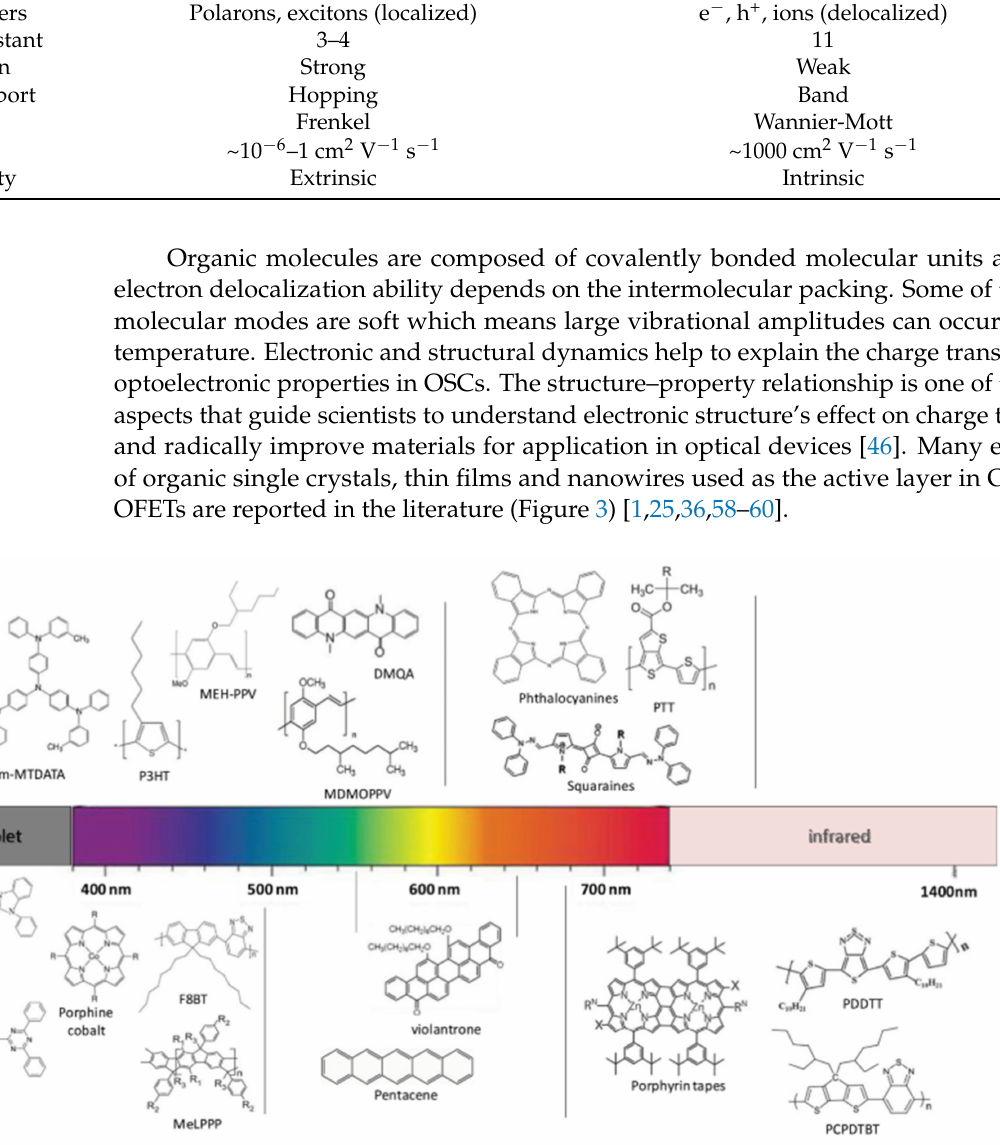
Figure 3. Some examples of OSCs in a broad wavelength range of the spectrum. Reprinted with permission from ref. [3]. Copyright 2013